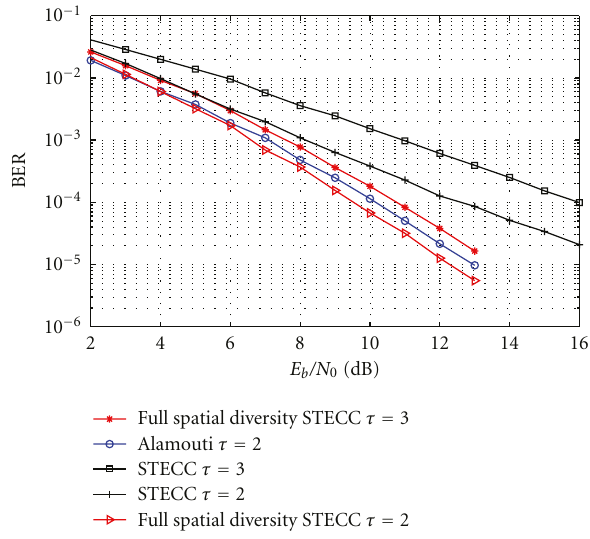
Figure 4: Performance of the full diversity STECC compared to suboptimal-diversity STECC [16] and Alamouti OSTBC